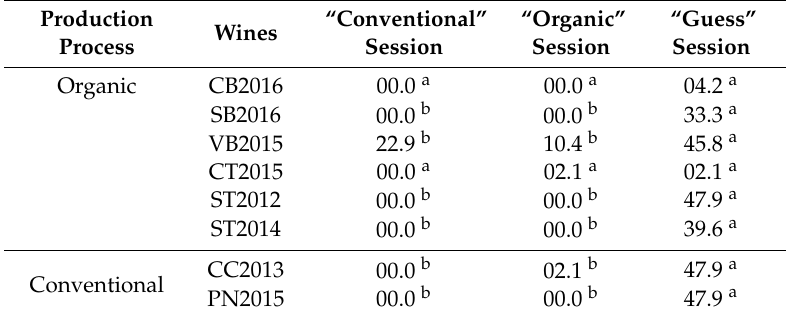
Table 10. Percentage of citation of the emotional descriptor “Unpleasant” on each wine tasting session for each wine *.